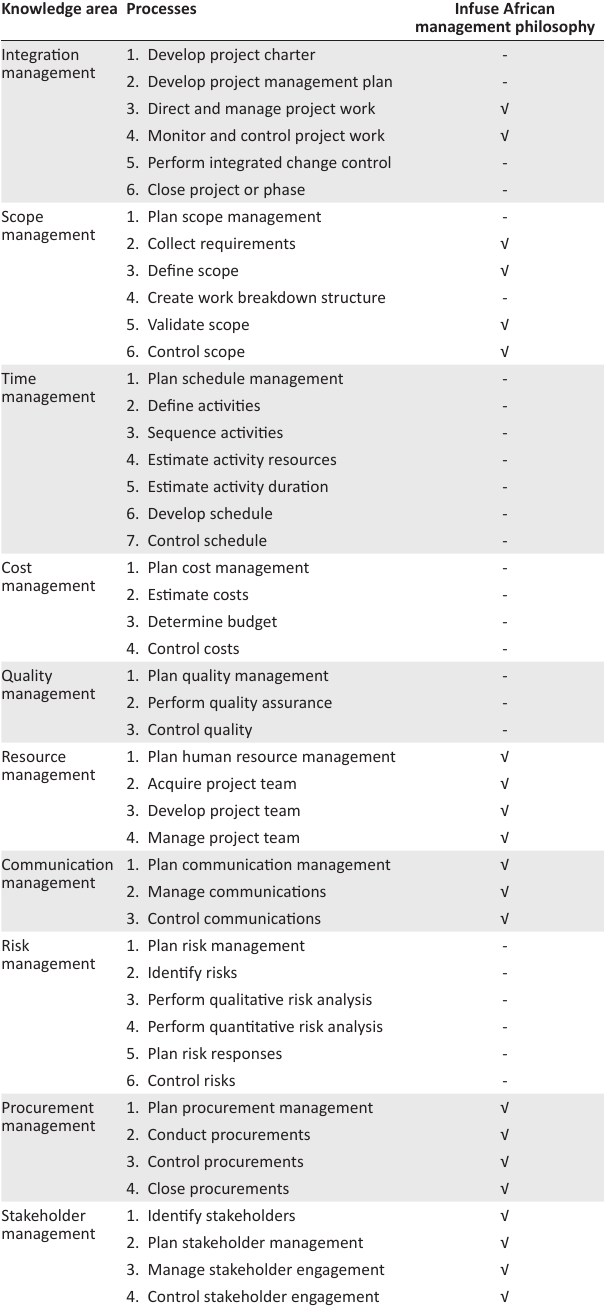
TABLE 1: Mapping of African management philosophy to Project Management Body of Knowledge Guide processes. Knowledge area